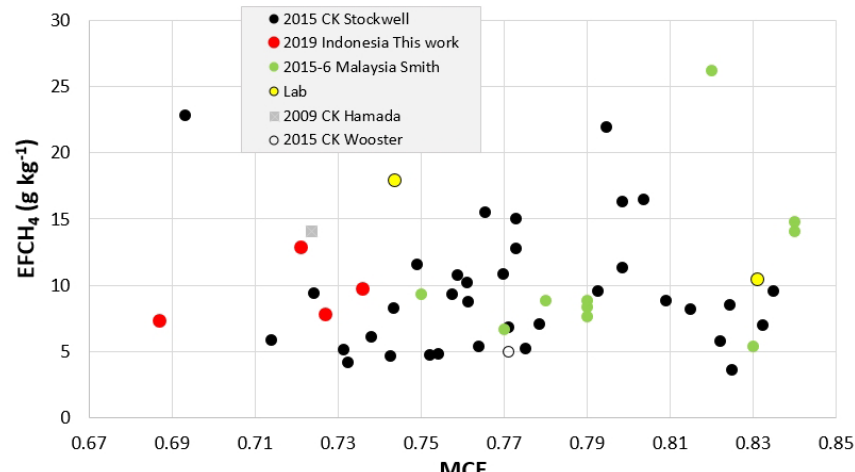
Figure 2. The emission factor for CH 4 (gkg − 1 ) versus MCE for field studies sampling pure peat fires in the tropics and lab studies of pure tropical peat smoke that also included extensive NMOG data. “CK” indicates the Indonesian province Central Kalimantan. Black: Stockwell et al. (2016a); red: this work (provincial averages); green: Smith et al. (2018); gray: Hamada et al. (2013); unfilled circle: Wooster et al. (2018). Lab data (yellow) shown are from fire no. 55 in FIREX (MCE = 0 . 831) and fire no. 114 in FLAME-4 (MCE = 0 . 744). See text for additional details.